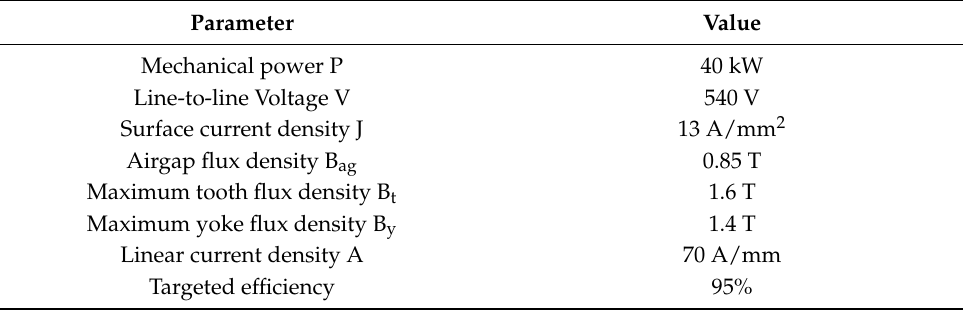
Table 2. Motor design parameters.